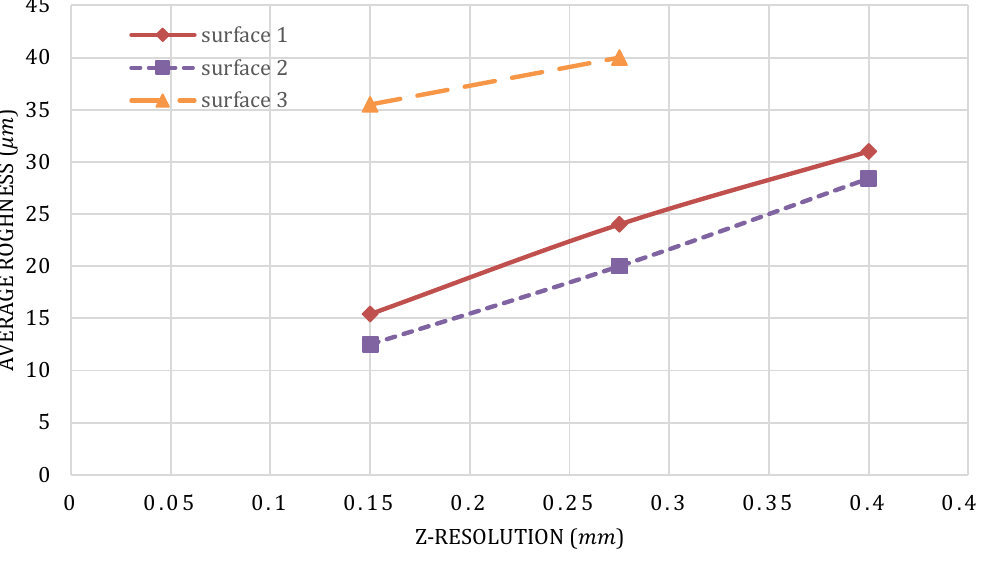
Figure 5: The R a value depending on Z-resolution of two sparse Fill samples